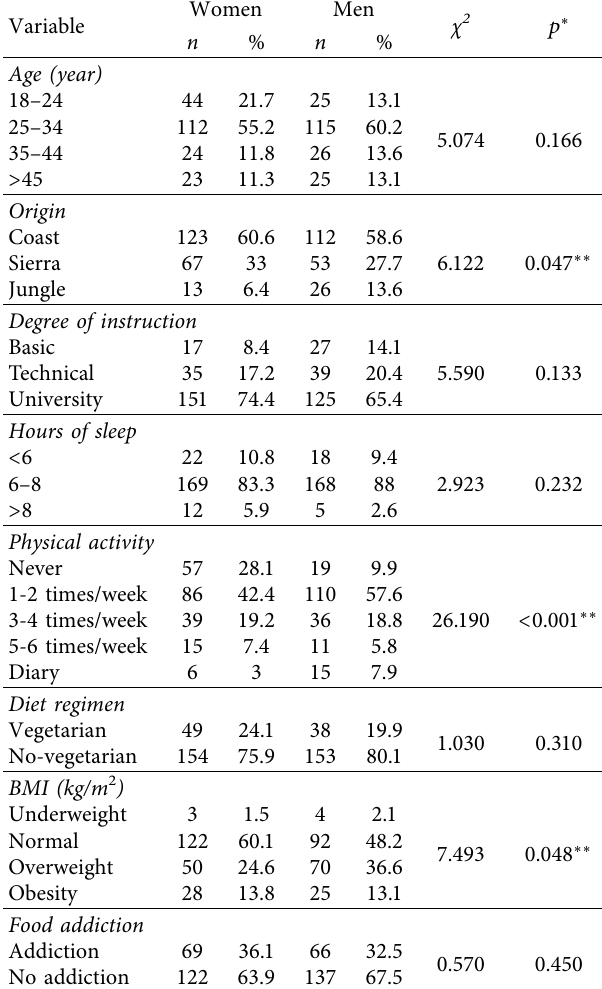
Table 1: Sociodemographic characteristics, lifestyle, diet, and BMI of the participants according to